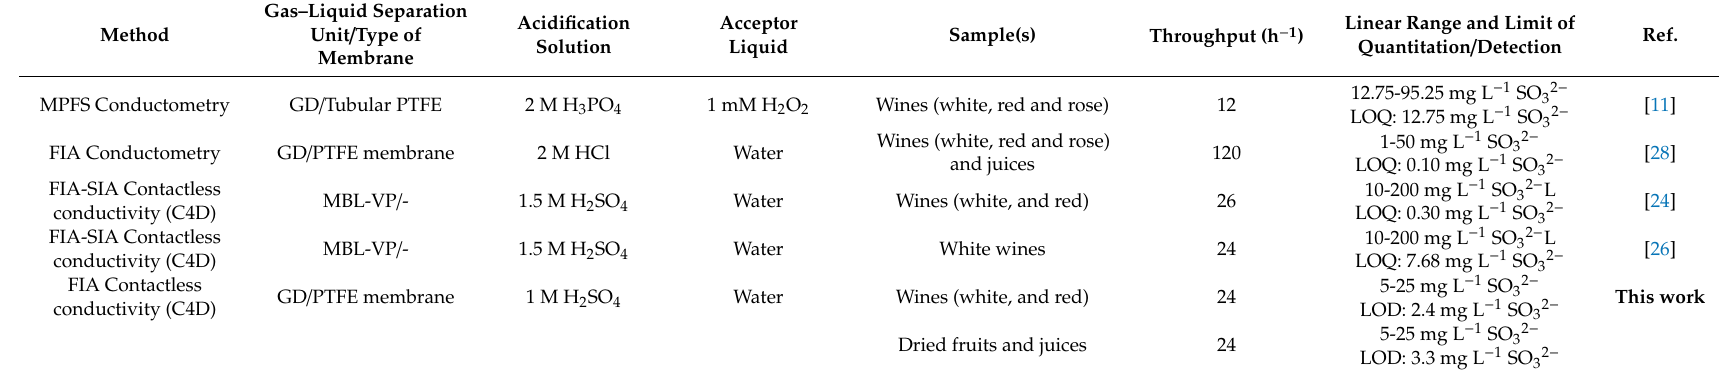
Table 3. Comparison of a flow-based system coupled with a gas–liquid separation unit for the conductivity detection of total